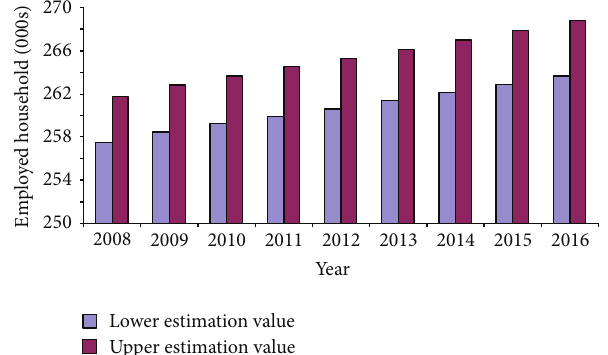
Figure 6: Projected household demand, 2008–2016. The lower estimation figure is based on head of household ratio by occupation, while the upper estimation figure is based on job to employed household ratio.